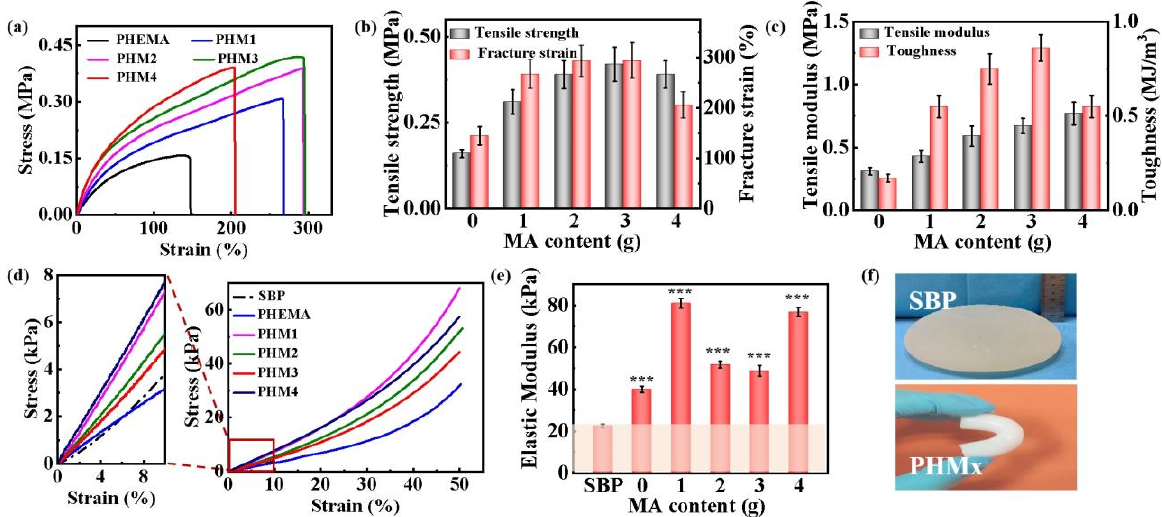
Figure 3. Mechanical properties of the hydrogels. ( a ) Tensile stress-strain curves of the PHMx hydrogels with different MA contents, and corresponding ( b ) tensile strength and fracture strain and ( c ) tensile modulus and toughness. ( d ) Compressive stress-strain curves of SBP and the PHMx hydrogels and ( e ) corresponding elastic modulus (NS represents no significant difference, * p < 0.05, ** p < 0.01, and *** p < 0.001). ( f ) Physical images of SBP and the PHMx hydrogels.